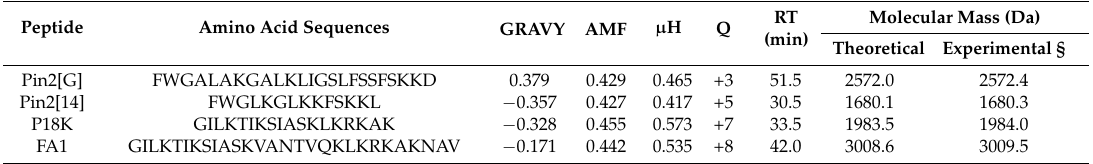
Table 1. Physicochemical properties of the synthetic peptides.